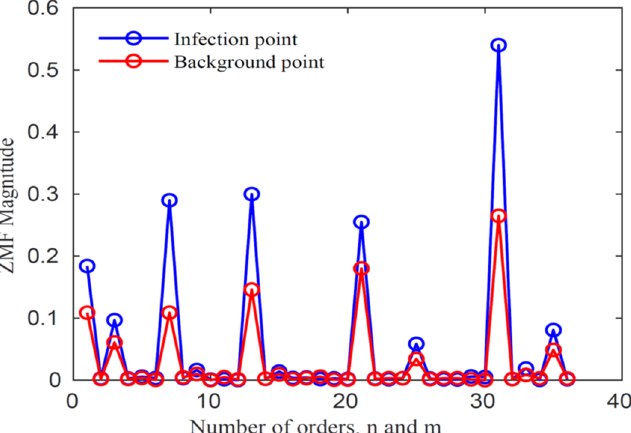
Figure 4. Experimental analysis for the extraction of 36 Zernike moment features (ZMF).